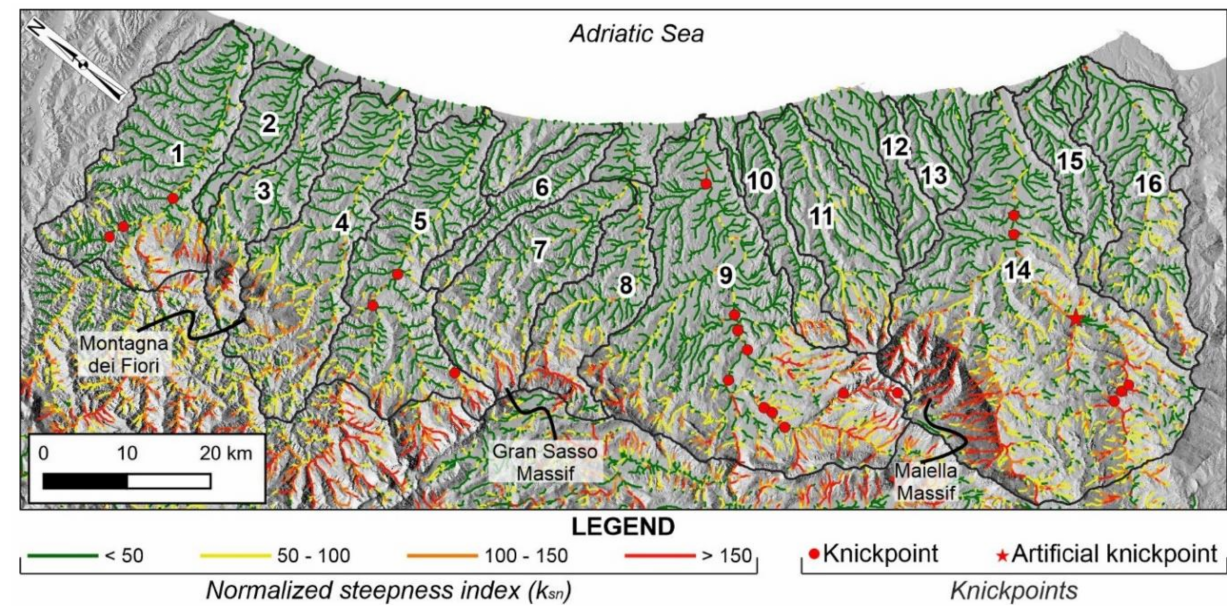
Figure 6. Normalized steepness index (k sn ) map. Red dots represent the knickpoint of the analyzed basins (i.e., Tronto R., Vomano R., Pescara R., and Sangro R.); red star represents the artificial knickpoint. Black lines represent the watershed of the main 16 basins analyzed. Numbers refer to the basins in Table